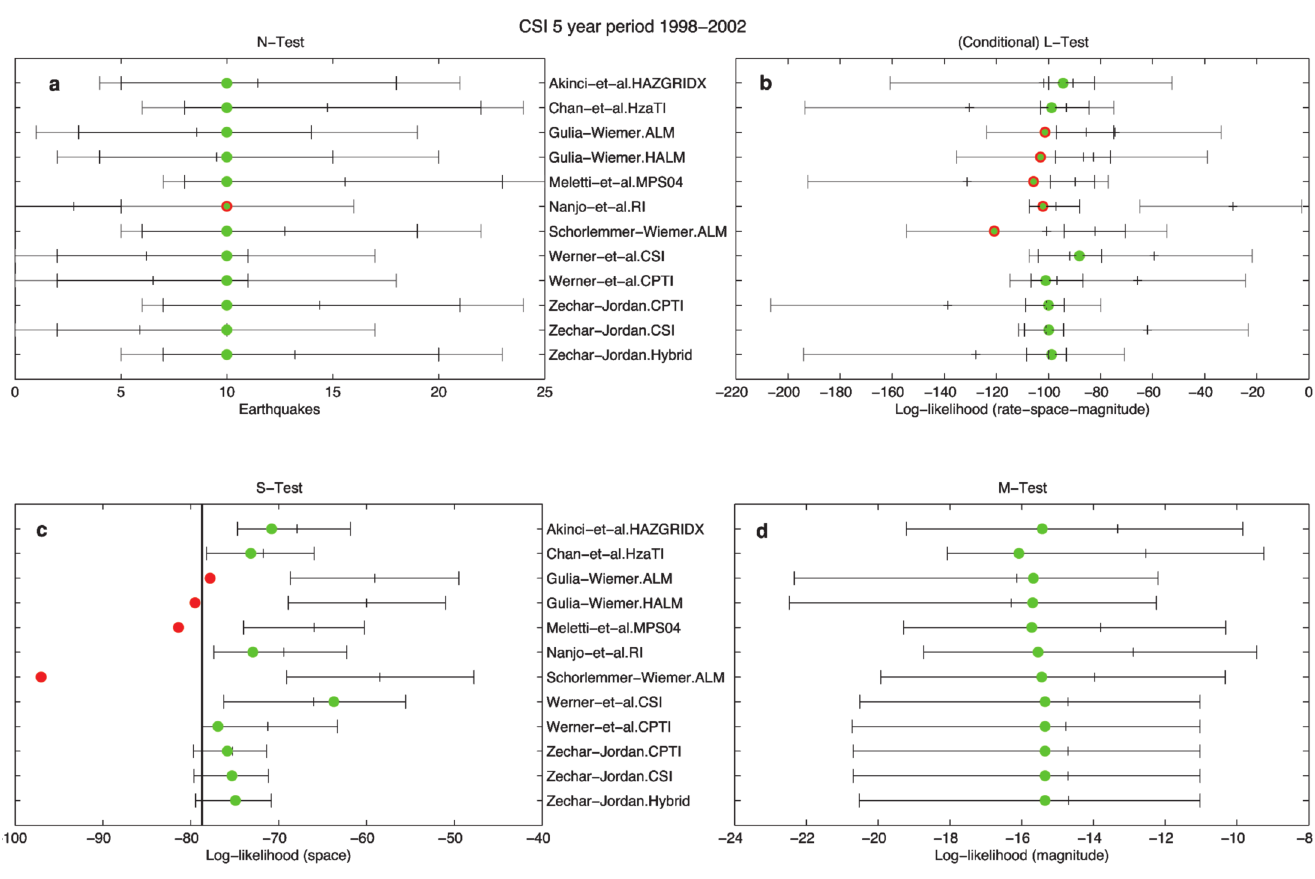
Figure 2. Results of the (a) N-Test, (b) unconditional/conditional L-Tests, (c) S-Test, and (d) M-Test of the 5-year time-independent forecasts using the 5- year target period from 1998 to 2002 of the data from the CSI. Red and green symbols, rejected and passed forecasts, respectively. In (a), green symbols with red edges, Poisson forecast was rejected while NBD forecast was passed. In (b), green symbols with red edges, only one of the two L-Tests was passed. Black crosses: (a) expected number of earthquakes; (b) expected unconditional/conditional log-likelihood score; (c) expected spatial log-likelihood score; (d) expected magnitude log-likelihood score, assuming the forecast was correct. Black bars: 95% confidence limits of the model forecasts assuming a Poisson distribution. In (a), gray bars, 95% confidence limits of the model forecast assuming a negative binomial distribution. In (b), gray/ black bars, 95% confidence limits of the unconditional/ conditional likelihood scores. In (c), vertical line, likelihood score of a spatially uniform